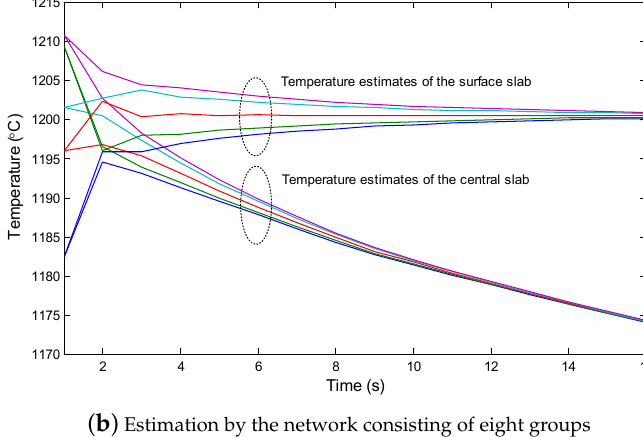
( b ) Estimation by the network consisting of eight groups Figure 11. The surface and central temperature estimates during the slab transfer into the interstand